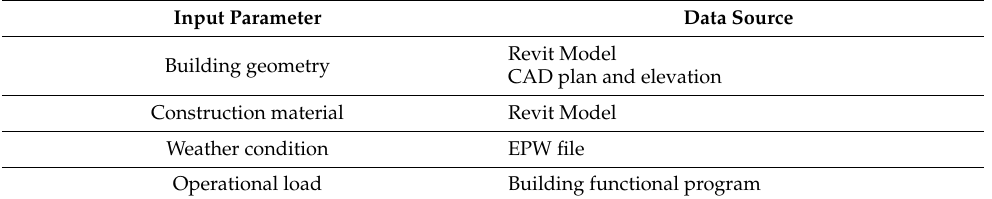
Table 3. Input parameters for the simulation model.